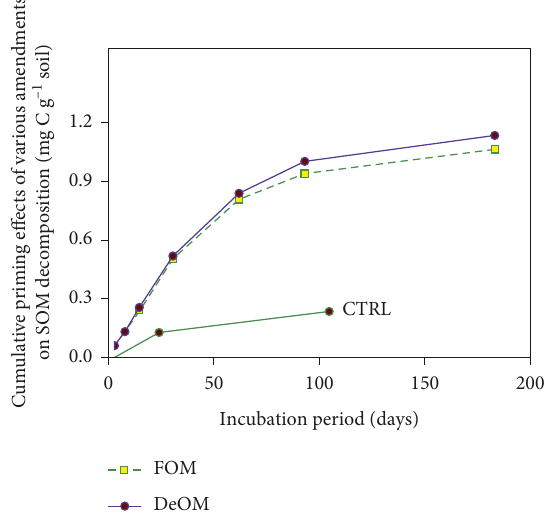
Figure 3: Priming effects of various amendments on SOM de- composition with time